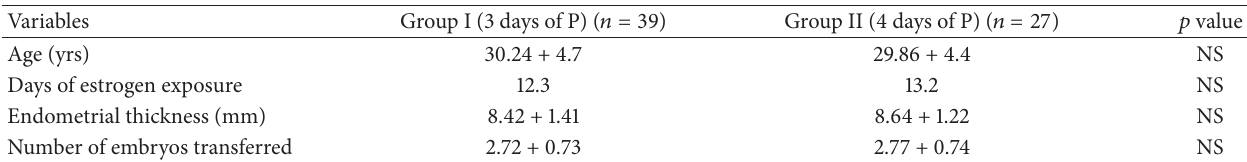
Table 1: Comparison of characteristics of the patients receiving progesterone for 3 and 4 days before embryo transfer.